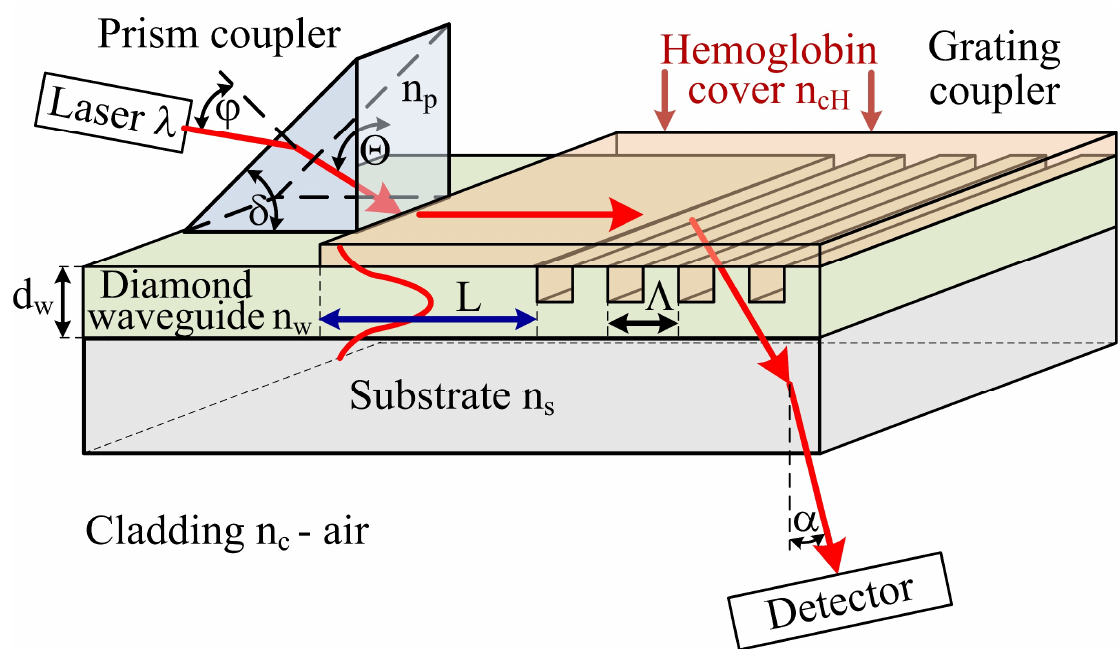
Figure 1. Scheme of the hemoglobin sensor structure, n p —refractive index of prism, n w —refractive index of waveguide layer, n s —refractive index of substrate, n cH —refractive index of hemoglobin cover layer, n c —refractive index of cladding, d w —thickness of the waveguide layer, φ —angle of incidence of the light beam from laser upon the prism, Θ —angle of incidence of the light beam upon the base of the prism, δ —breaking angle of the prism, L —length of the waveguide with hemoglobin cover layer, α —angle of the uncoupling light beam by grating coupler, Λ —spatial period of the grating coupler, λ —wavelength of